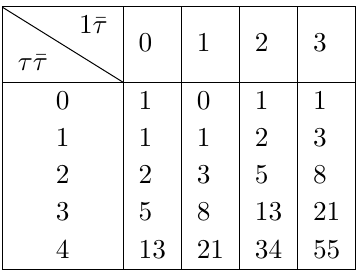
Table 3 . State counting on a disk with both real (cid:28) (cid:22) (cid:28) ’s and 1(cid:22) (cid:28) ’s.